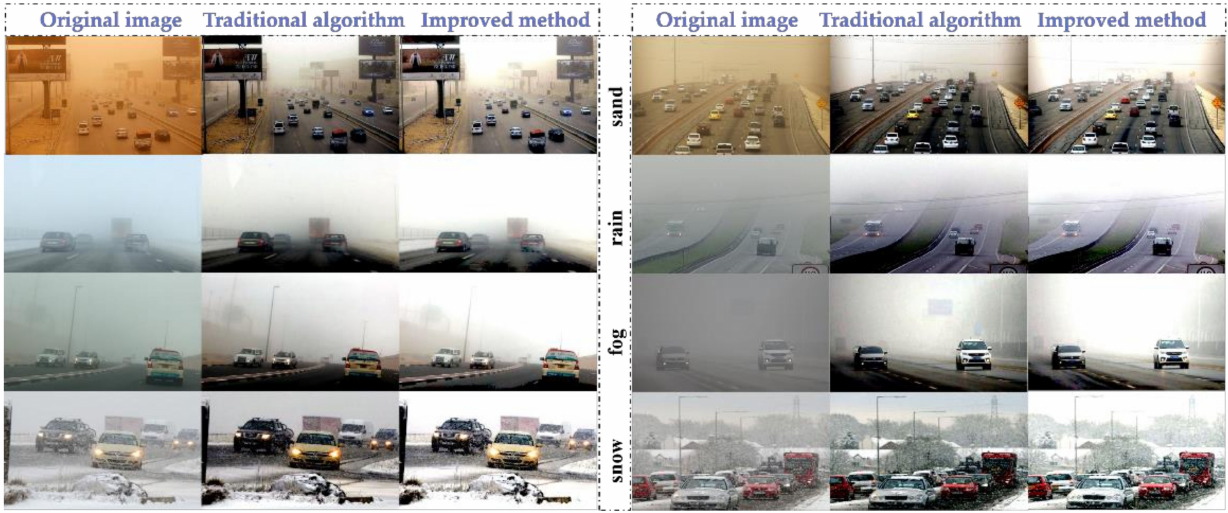
Figure 4. Comparison of before and after improvement of auto color levels